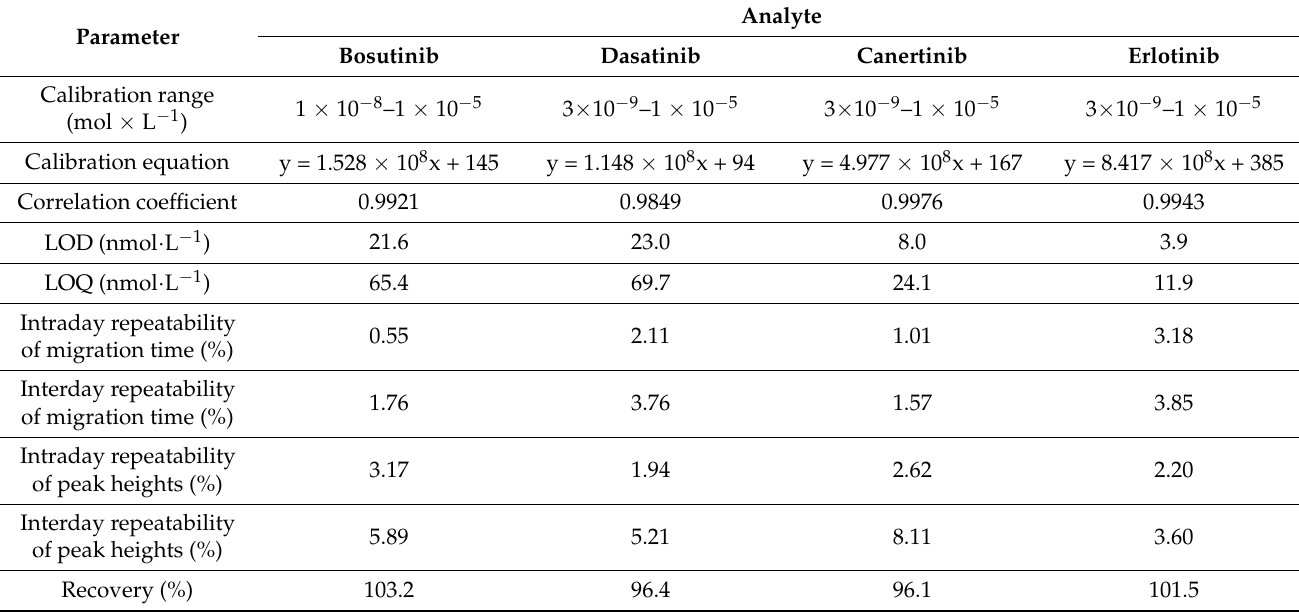
Table 2. Summary of the method